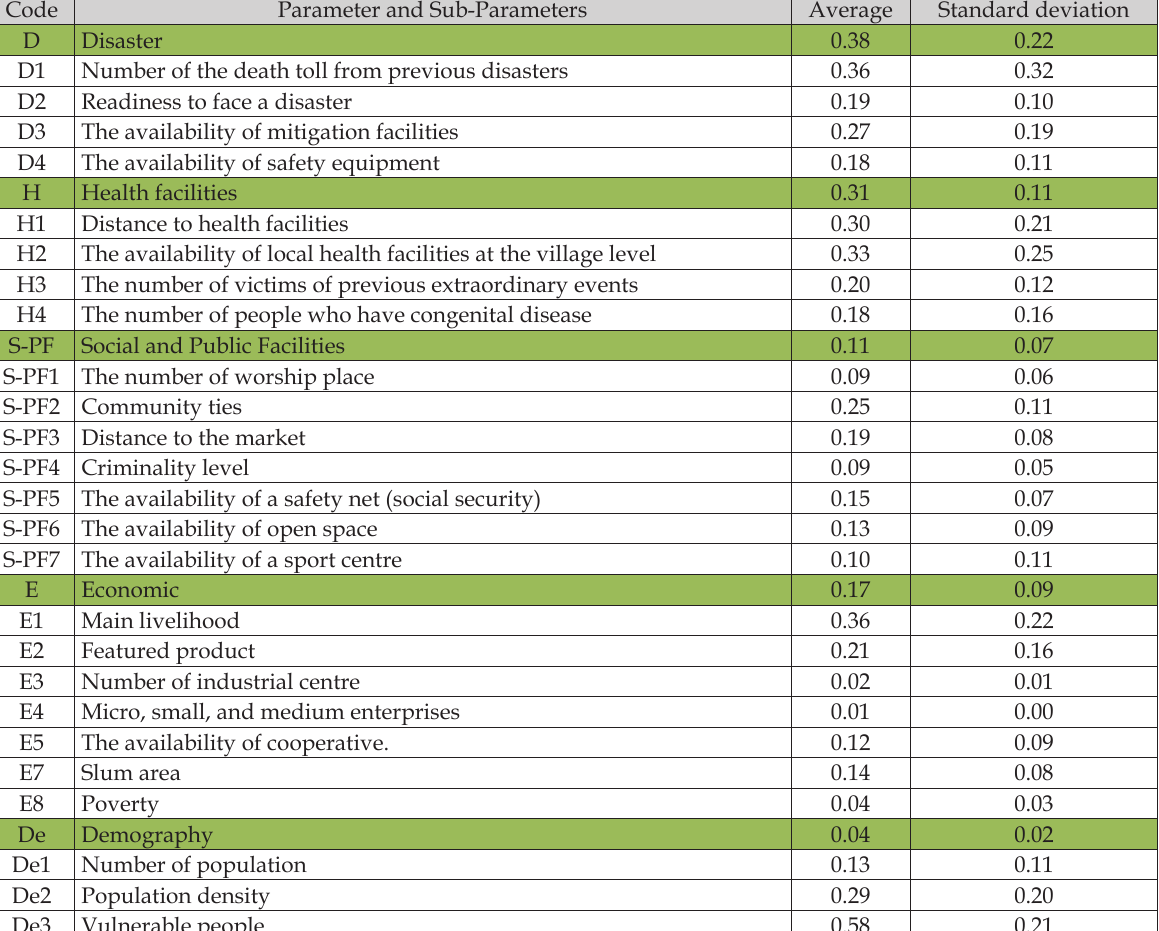
Table 7. The summary of AHP results (green colour –